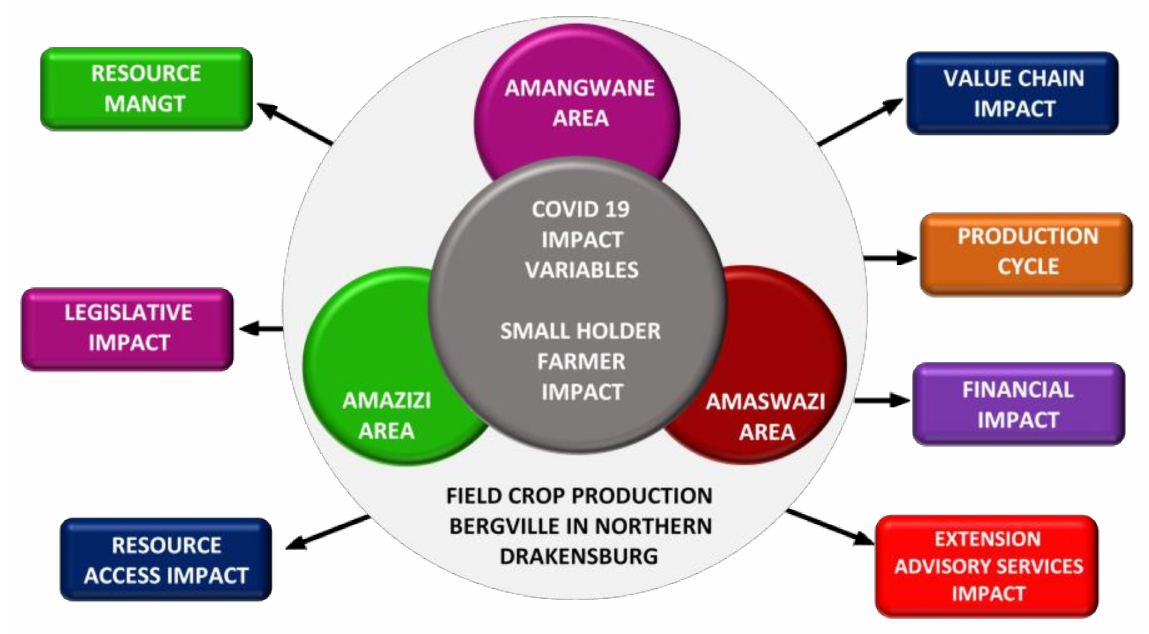
Figure 2. Variables highlighting direct impacts on farming operation during